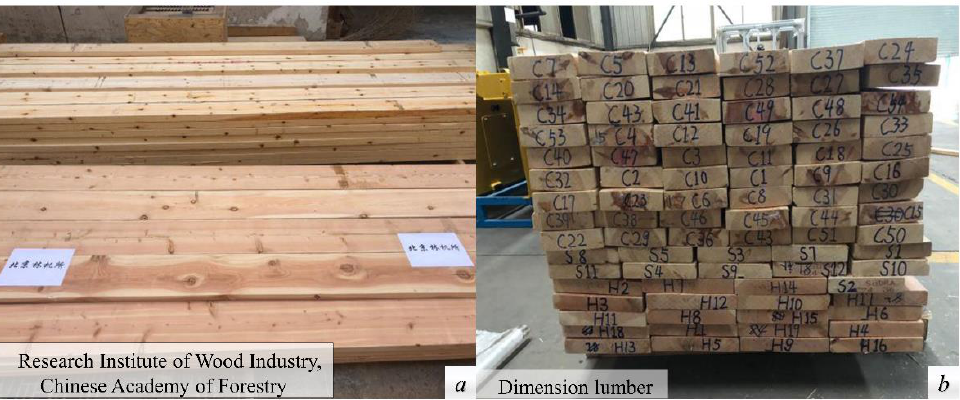
Figure 1. The tested dimension lumber. ( a ) Research Institute of Wood Industry, Chinese Academy of Forestry ( b ) Dimension lumber.